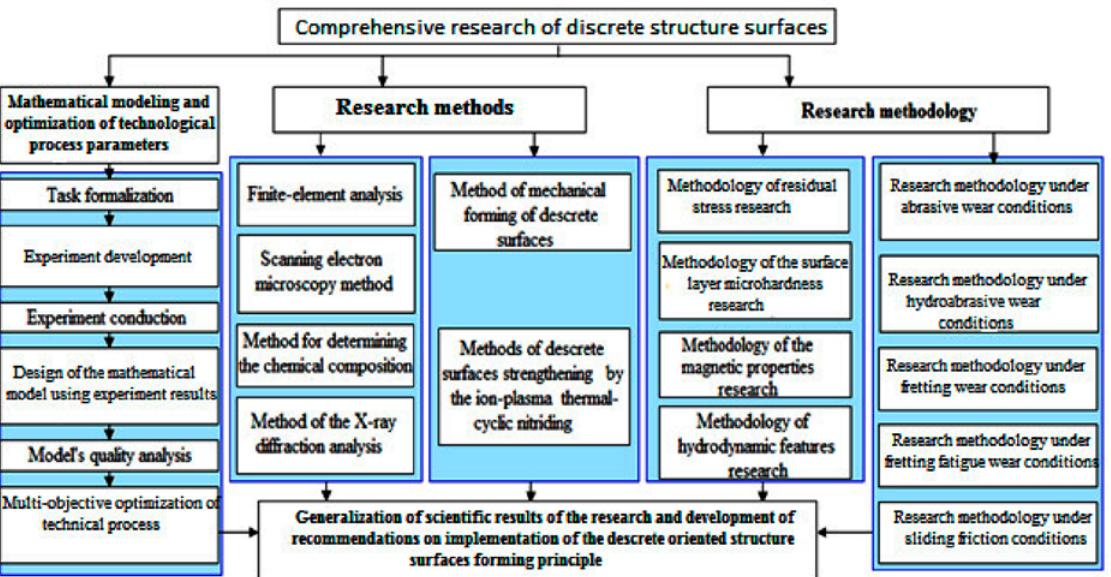
Fig. 2. The systematic approach and comprehensive nature of research of discrete